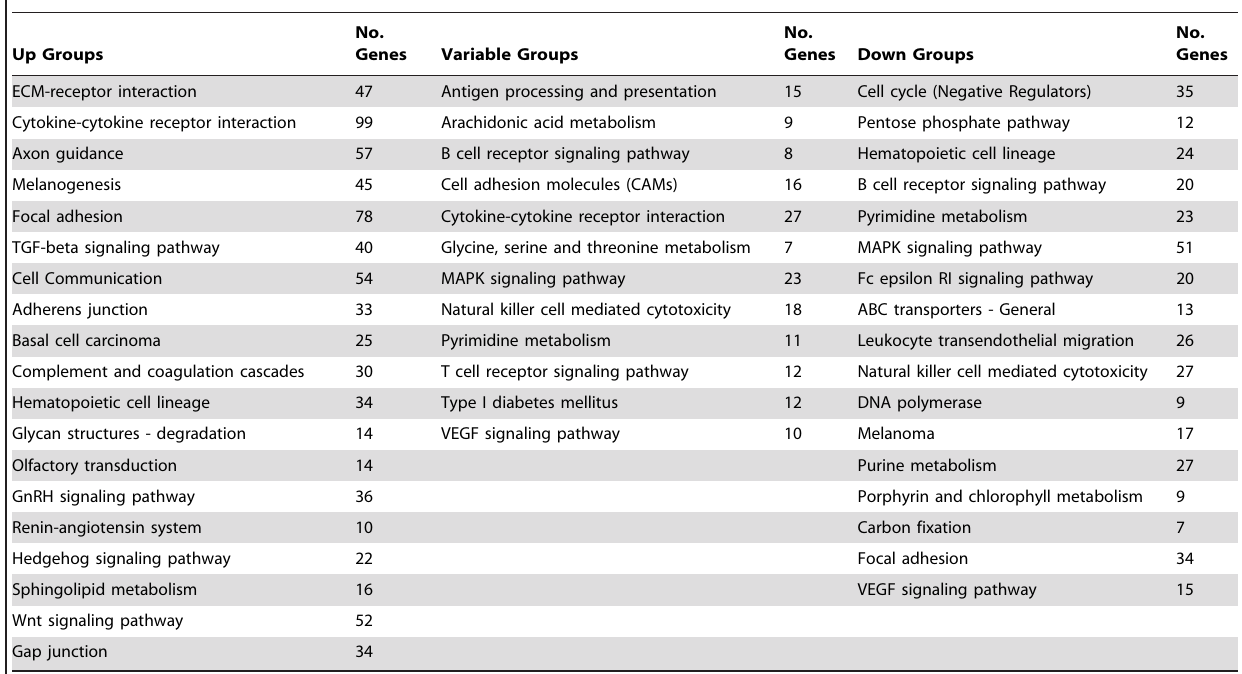
Table 2. Identified KEGG* Pathways in the General Temporal Groupings